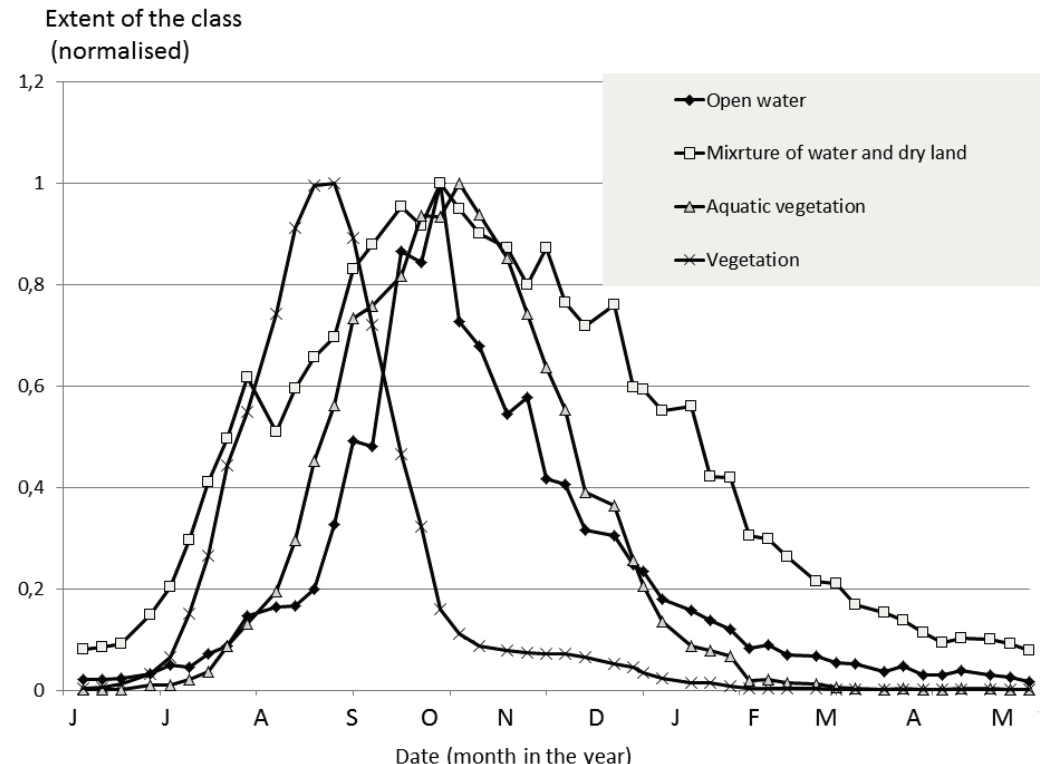
Figure 4. Normalized total extent of each of the classes over the Inner Niger Delta (IND) during a hydrological year (starting in June, finishing in May). All years have been averaged over each time portion of eight